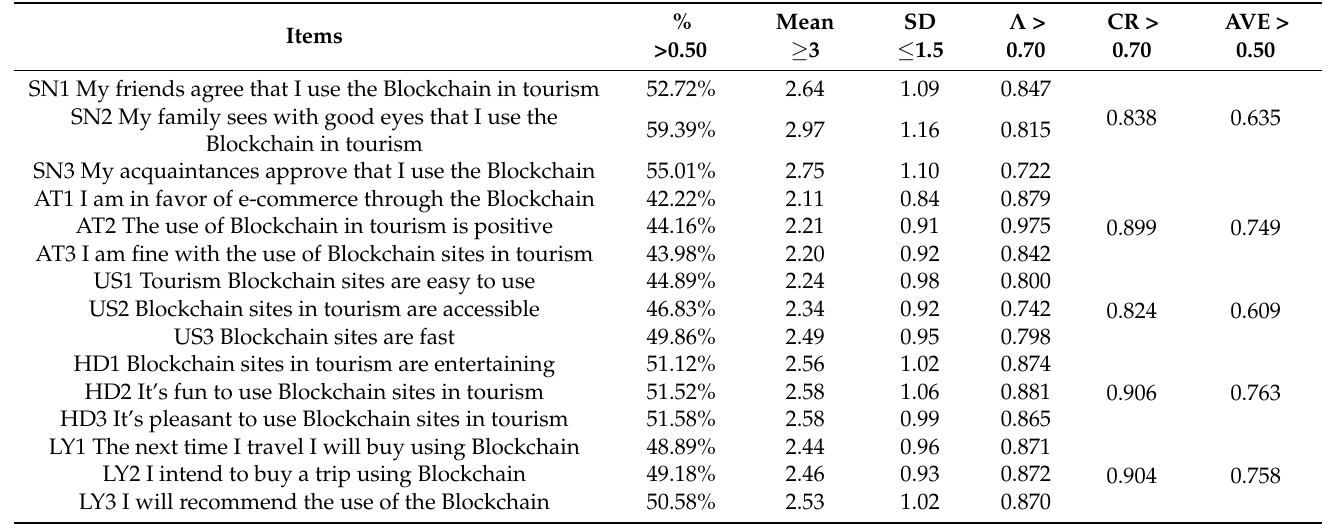
Table 2. Descriptive and measurement model basic